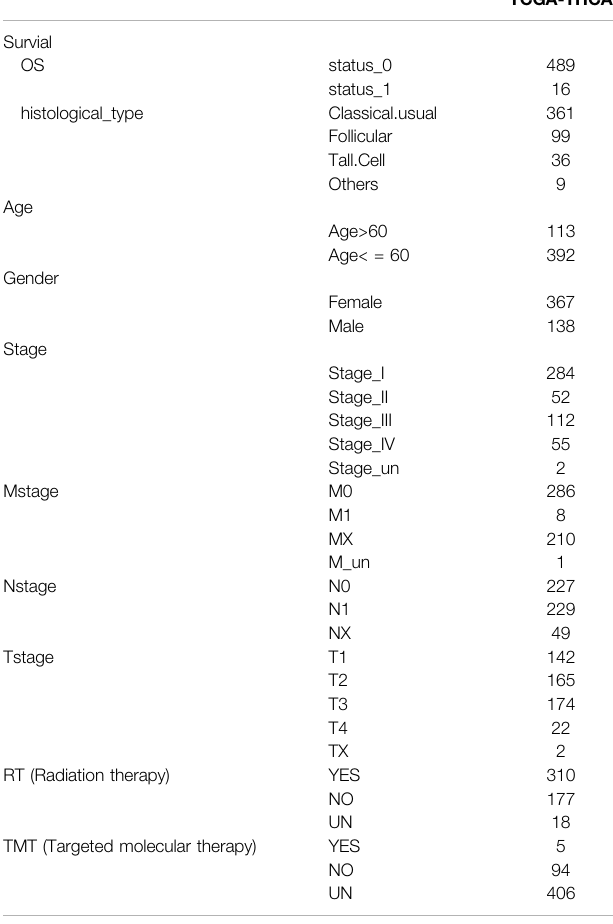
TABLE 1 | Clinical information of TCGA-THCA